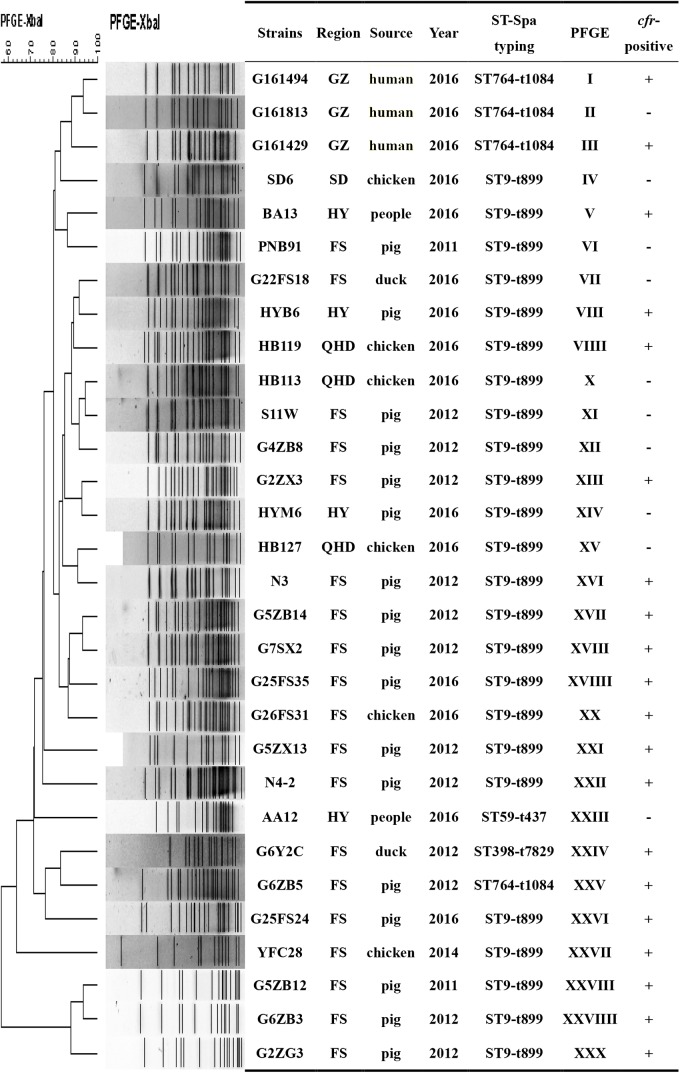
PFGE fingerprint patterns of SmaI-digested total DNA preparations from 20 MRSA strains harboring cfr and 10 cfr-negatives MRSA strains. A similarity cutoff of 100% was used to identify a PFGE cluster. Guangzhou (GZ), Qinhuangdao (QHD), Foshan (FS), Shandong (SD), Huadu (HD), and Heyuan (HY). “+”, cfr-positive; “–” <LIST>cfr-negative.